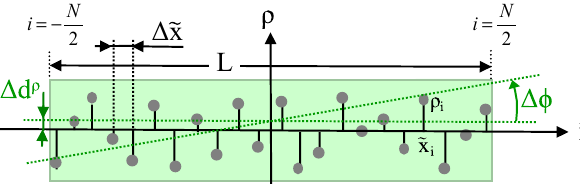
Figure 4. Details of Figure 3 with the deviation of data points along the axis ˜ x